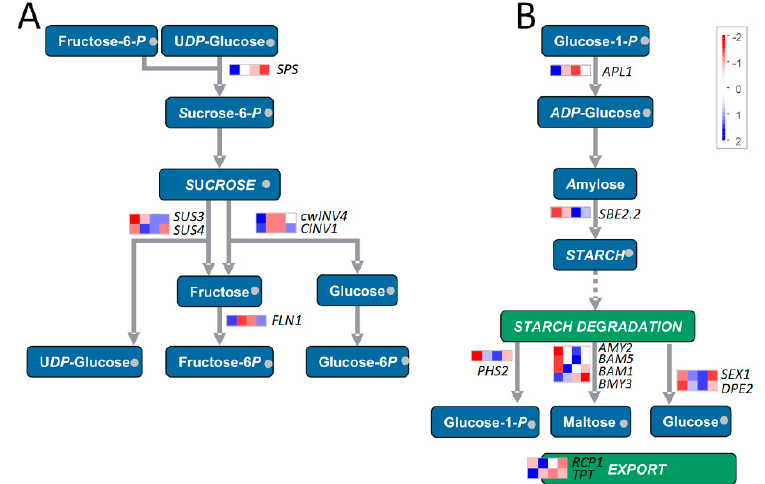
Figure 5. Diagram of DE genes related to sucrose ( A ) and starch ( B ) biosynthesis-degradation pathways. The analysis is performed in the MapMan software. The FPKM values are transformed by 2-based logarithm and then normalized by row as scaled by the color bar. Each row indicates a single gene, and the cells (from left to right) represent the samples from 0, 6, 12, and 24 h after salt treatment, respectively.